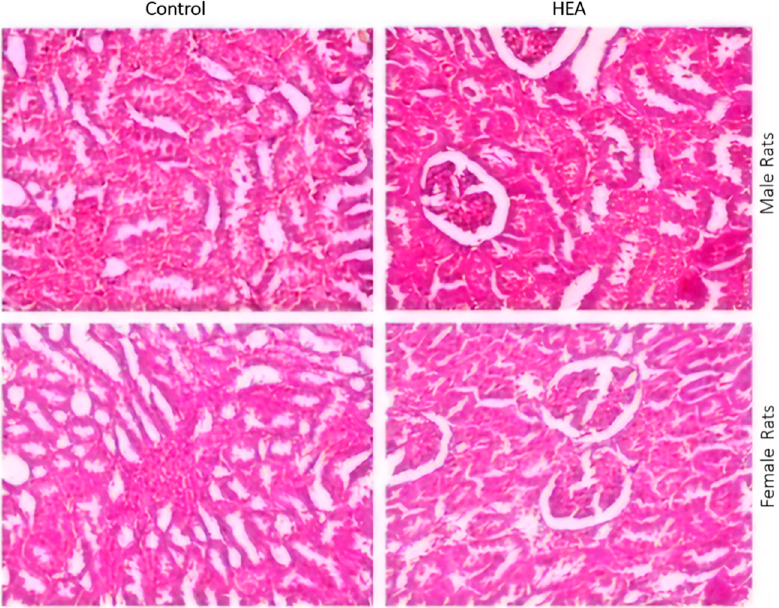
Figure 6. Histopathological examination of H&E stained sections of kidney of male and female albino rats administered 2500 mg/kg body weight of HEA as compared to control (0 mg/kg body weight) using 1200× magnification power.